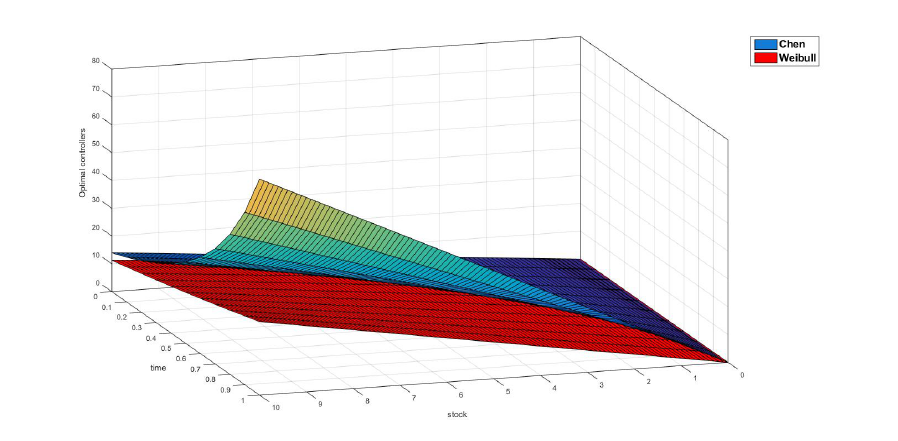
Figure 8. Optimal Weibull (red) and Chen (blue) controllers when δ 1 = 2 = δ 2 and λ 1 = 1 = λ 2 for ( t , x ) ∈ [ 0,1 ] × [ 0,10 ] .